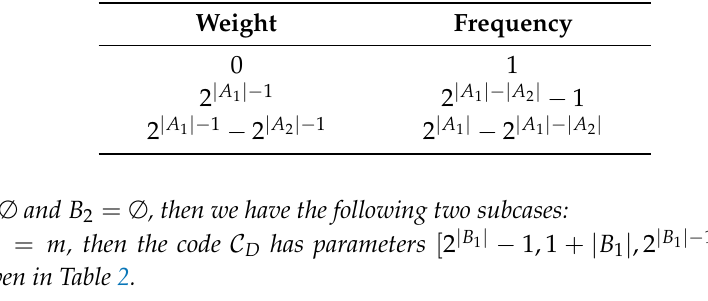
Table 1. Weight distribution of the code in Theorem 1 (1).